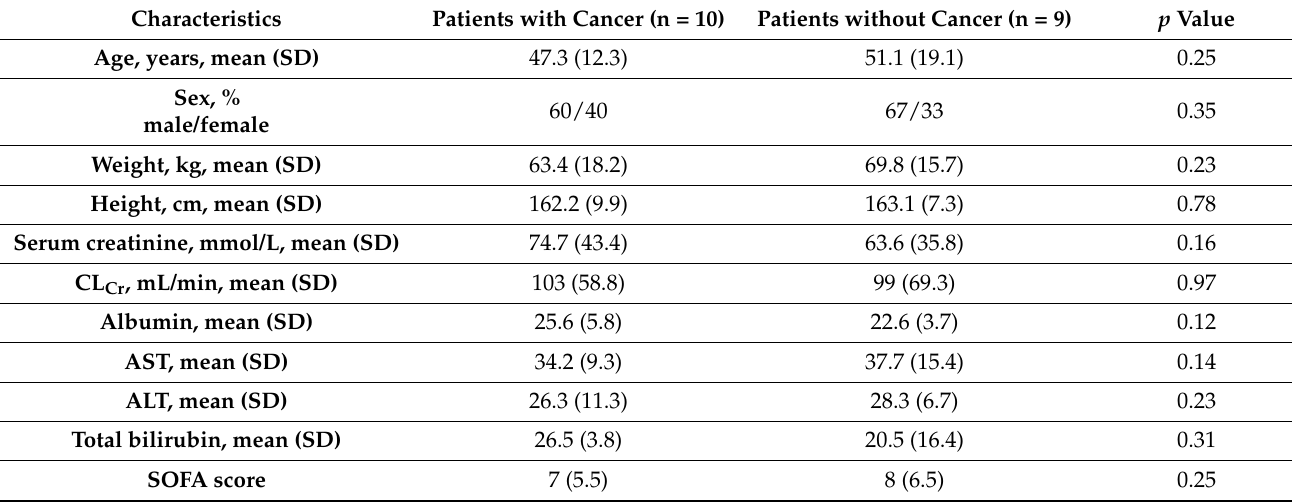
Table 1. Clinical and demographic characteristics of patients included in the study.